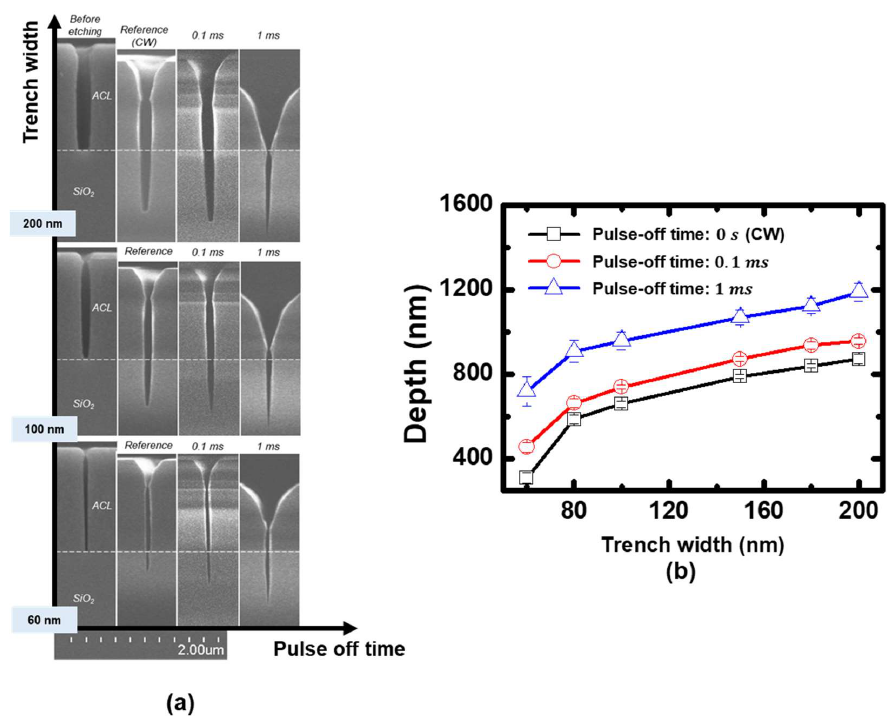
Figure 7. ( a ) Etching profiles measured through SEM, ( b ) measured silicon oxide etching depth un- der the pulse-modulated plasmas with various pulse-off time in C 4 F 8 20%. the pulse-modulated plasmas with various pulse-off time in C 4 F 8